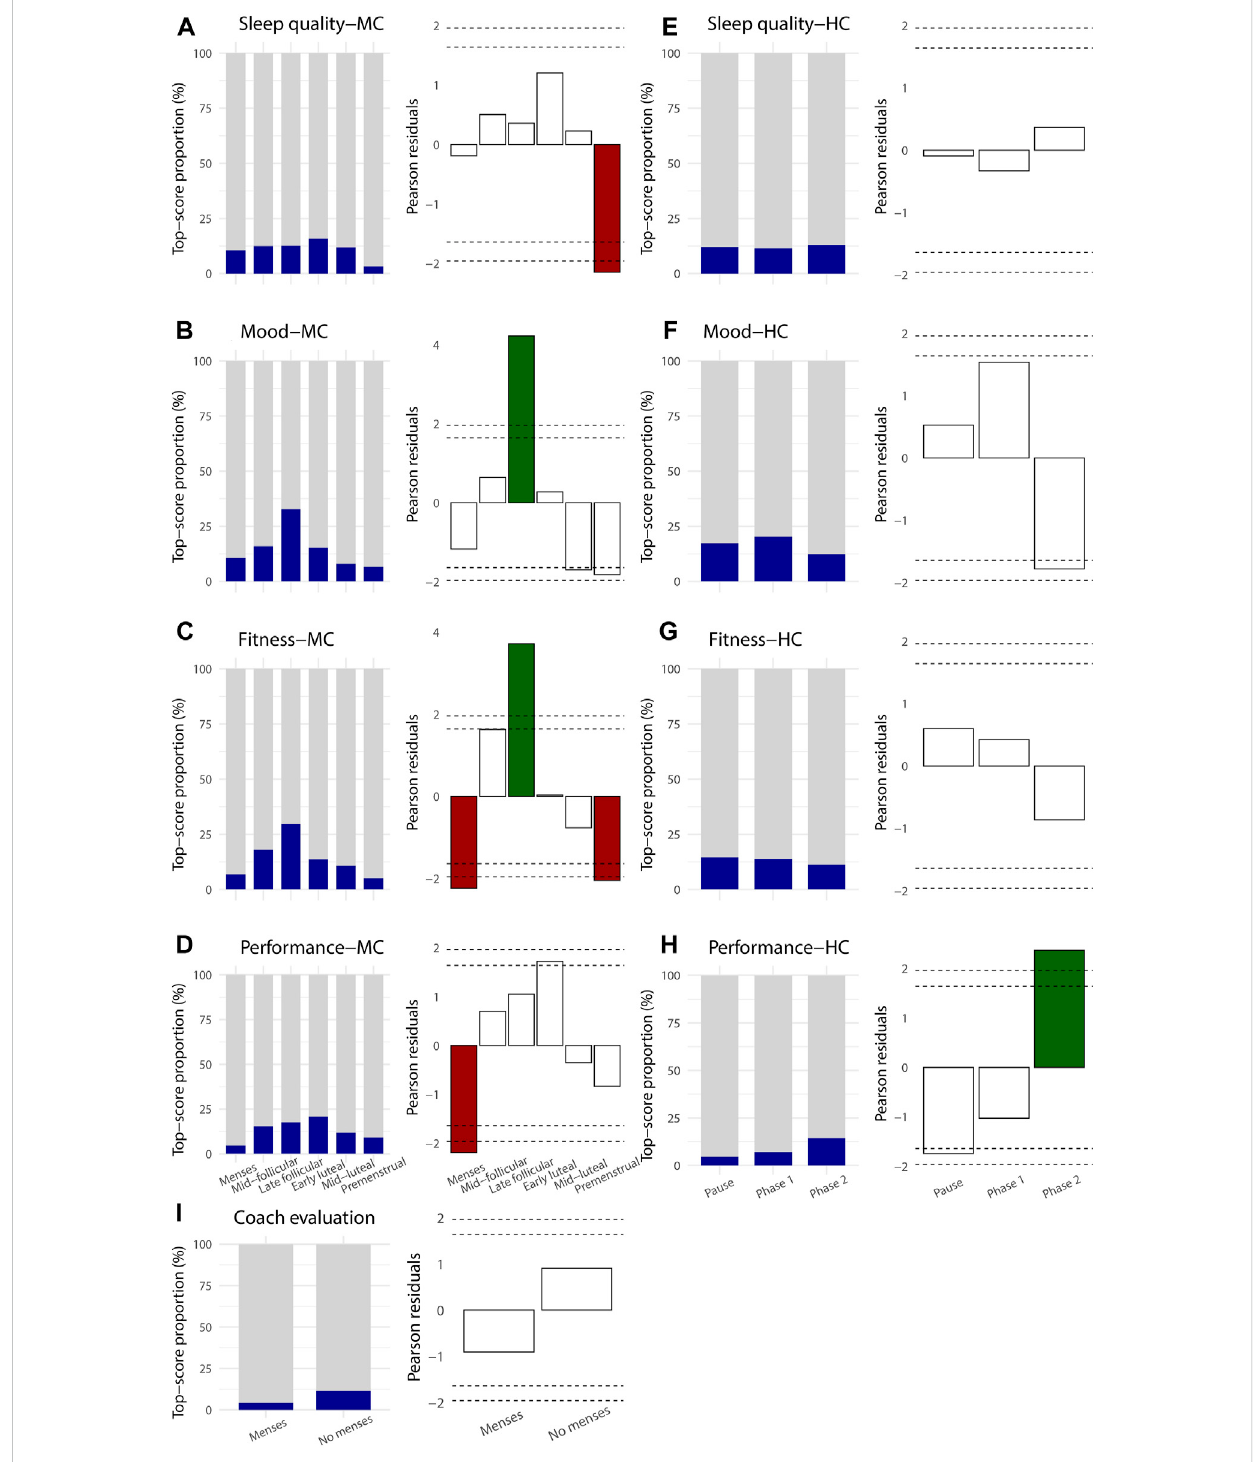
FIGURE 2 Proportionof the top quintile score of self-evaluation of daily wellness (A, B, C, D, F, G) and performance (D, H) parameters (dark blue) according to the cycles ’ phases in naturally MC rowers ( fi rst column (A – D) ) and hormonal contraception rowers (3 rd column (E – H) ). Pearson residuals of the corresponding top quintile scores in MC (2 nd column) and HC rowers (4 th column) representing the deviation from the homogeneous distribution of the upper quintiles among the cycles ’ phases. Green column: signi fi cantly higher proportion of top quintile score ( z > z crit ); red column: signi fi cantly lower proportion ( z < z crit ). The dotted line at ± 1,96 indicates a Z c atthe threshold of α = 0.05 and the dotted line at ± 1.64 indicates a Z c at the threshold of α = 0.1. The I) plot corresponds to the coach ’ s perception of the athlete ’ s performance, according to their menstrual status and the corresponding Pearson